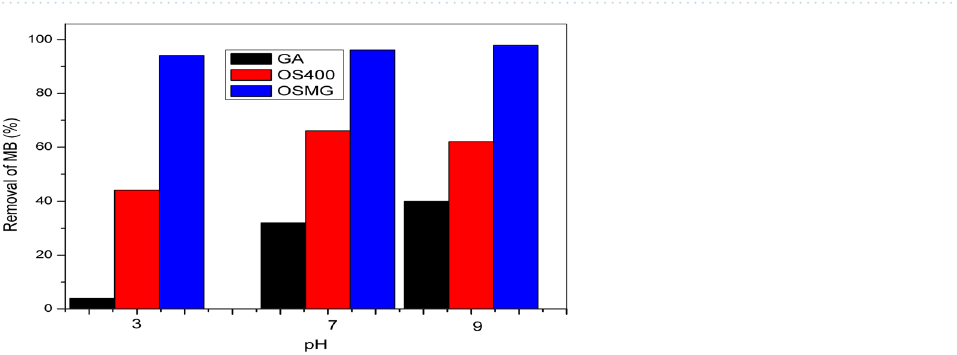
Figure 6. Effect of different concentrations of MB dye adsorbed onto GA, OS400 and OSMG.